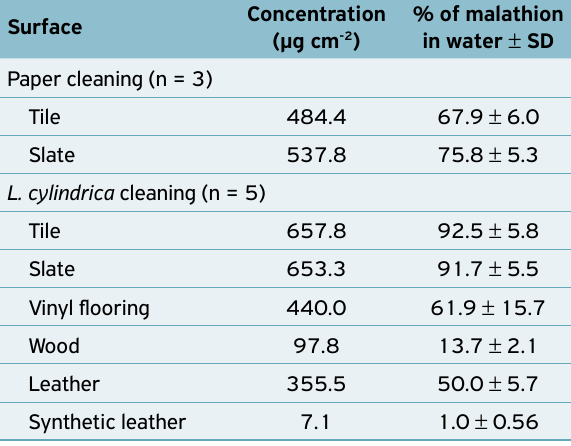
Table 1. Percentage of malathion removed from surfaces. Surface